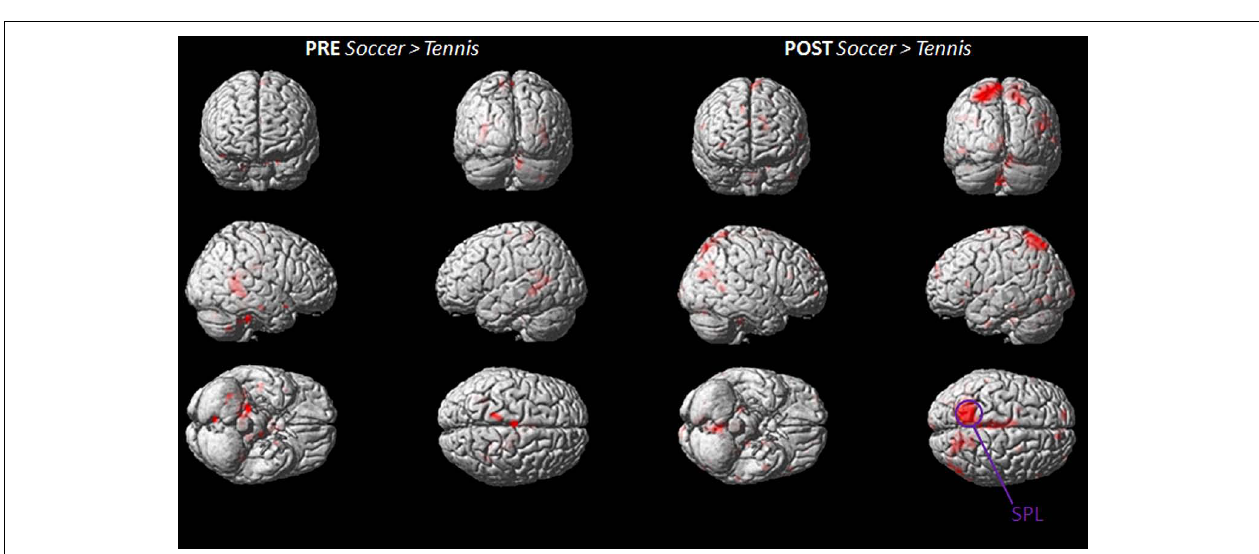
voxels are depicted on a rendered MNI brain. DLPFC = dorsolateral prefrontal cortex; SPL = superior parietal lobule; IPL = inferior parietal lobule; M1 = primary motor cortex; SMA = supplementary motor area.